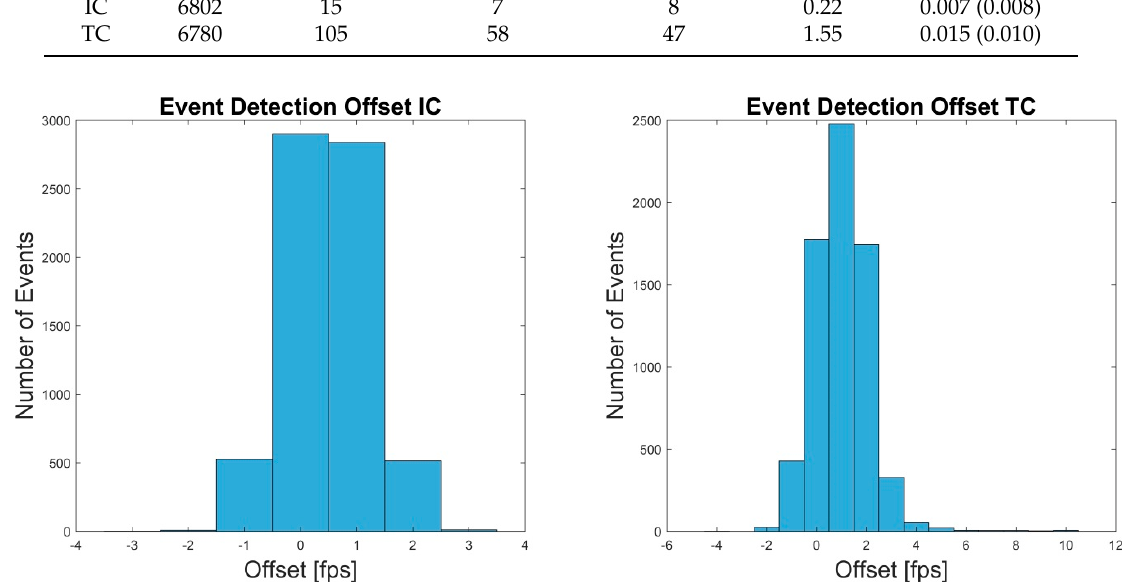
Figure 7. The Offset in frames per second (fps) between OMC and IMU system for the events IC and TC of retest are shown.